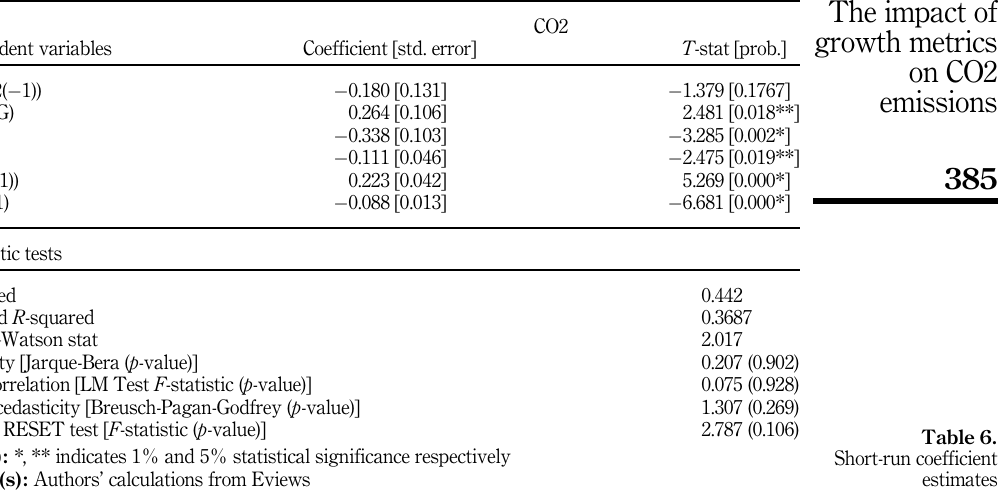
Table 6. Short-run coefficient